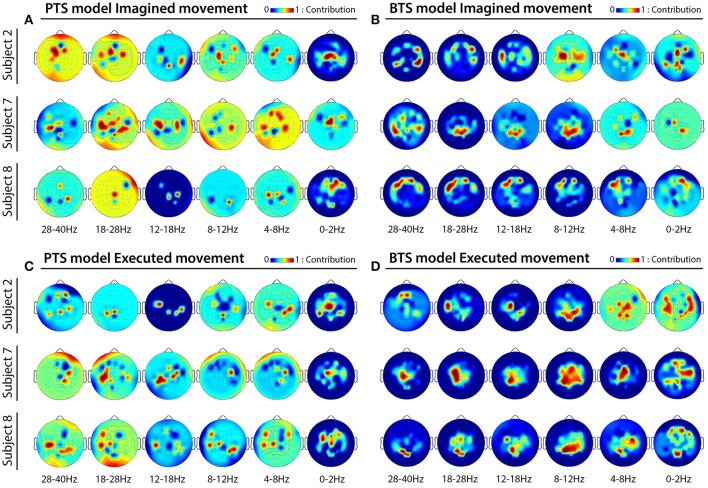
Subject specific topographical maps. Topographical distribution of electrode contribution to the reconstruction of imagined and executed arm movements for subjects 2, 7, and 8 [i.e., subjects for whom reconstruction accuracy was highest (see Figure 6)]. Color coding—contribution of significant channels [p < 0.05, Student two-tailed t-test corrected for FDR (false discovery rate)] based on accuracy rates of single channel setups in 6 × 5 inner folds indicating cortical areas providing a high contribution for trajectory decoding. (A,C) Present topographical maps for imagined and executed arm movements using band-pass filtered potentials for the PTS model, respectively. (B,D) Present topographical maps for imagined and executed arm movements using PSD values for the BTS model, respectively.